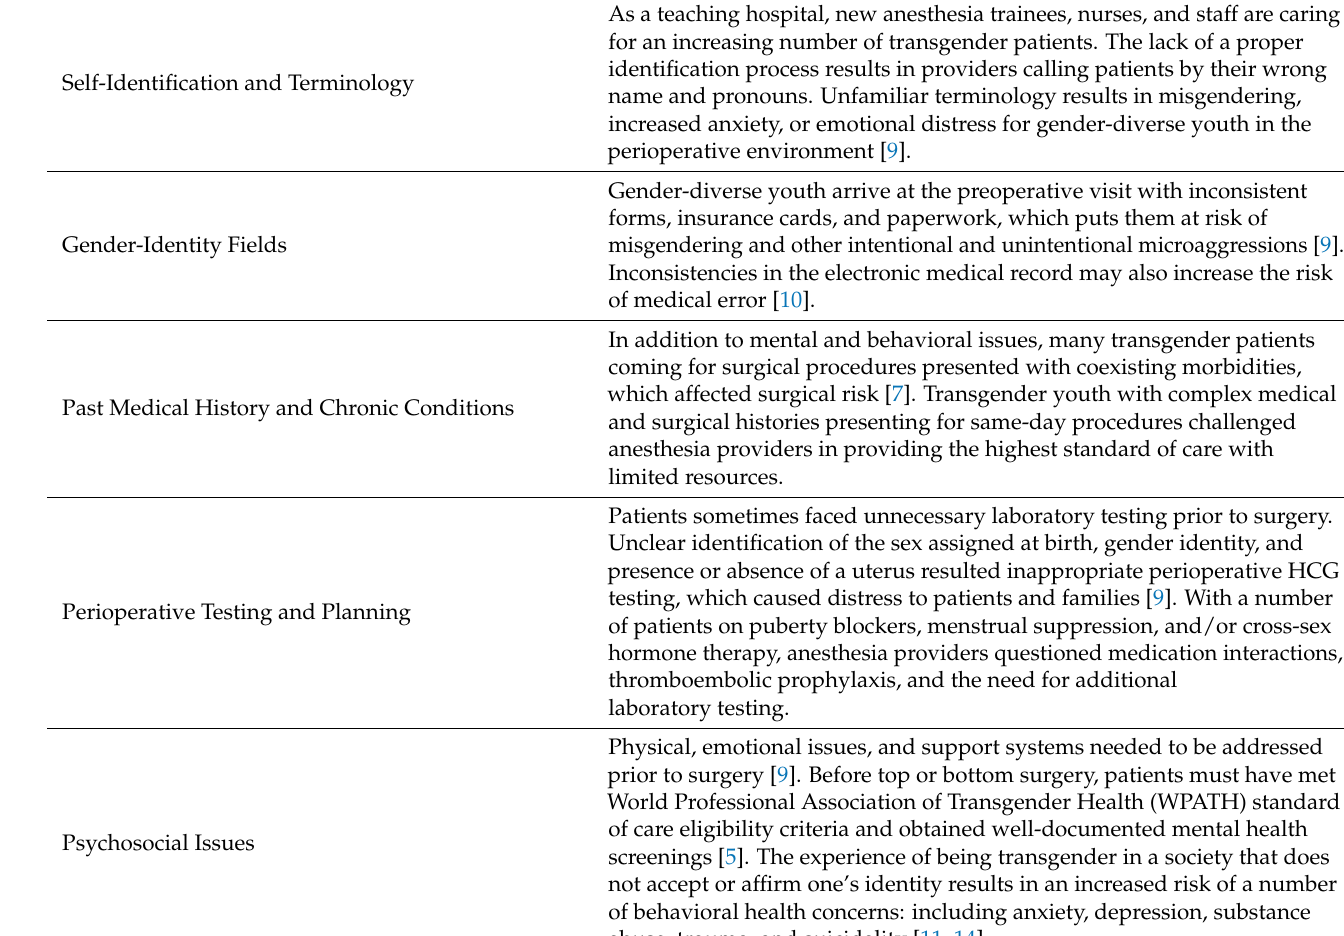
Table 4. Perioperative Complexities Unique to Gender-Diverse Youth identified by Anesthesia